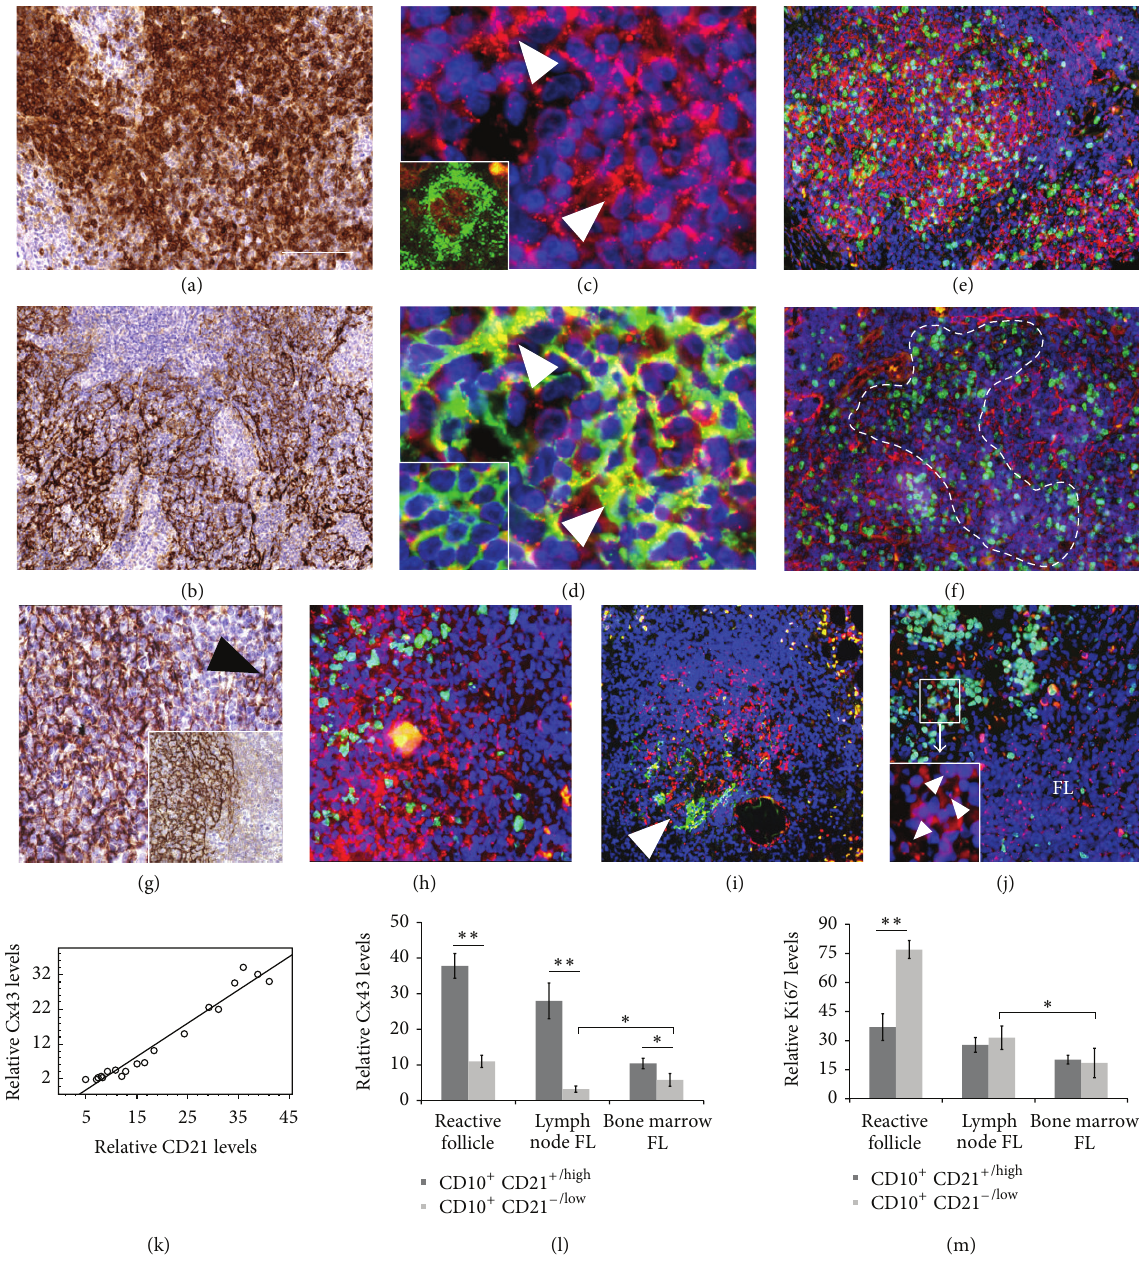
Figure 4: Connexin 43 expression in follicular lymphomas (FL); lymph node localization ((a)–(f)); and bone marrow involvement ((g)–(j)). Large and irregular follicles dominated by CD10 positive FL B cells (a) and fragmented CD21 positive FDC meshwork (b). Cx43 ((c), red) reaction colocalizes with that of CD21 ((d), green) in yellow (arrowheads). Insets show a binuclear FDC with highly upregulated Cx43 ((c), green),and colocalization of Cx43 (red) and CD10 (green) as yellow dots (d). Elevated tumor cell proliferation detected with Ki67 reaction (green) is seen in FL follicles either with dense FDC and Cx43 reactions ((e); red) or with fragmented FDC and Cx43 staining ((f); circled area highlights broken or missing FDC). In the bone marrow involvement of FL NGFR (g) and CD21 (inset) positive follicles (arrowhead: LNGFR positive hyperplastic stromal cells) show the most of Cx43 reaction ((h), red) and proliferating tumor cells (Ki67-green). Strong Cx43 staining ((i), red) is accompanied with only fragmented CD21 reaction (green) in another follicle. Significantly more Cx43 (red) but less Ki67 (green) is detected within a bone marrow FL infiltrate than in the rest of bone marrow (j). Arrowheads in the inset show Cx43 within the boxed area. Graphs reveal linear correlation between Cx43 and CD21 levels in FL (k) and Cx43 (l) or Ki67 (m) expression in FDC rich and FDC poor FL areas. Immunoperoxidase ((a), (b), and (g)) and immunofluorescence staining ((c)–(f) and (h)–(j)). Blue nuclear staining using hematoxylin ((a), (b), and (g)) or Hoescht ((c)–(f) and (h)–(j)). Significance: ∗ 𝑃 < 0.05 and ∗∗ 𝑃 < 0.005 . Scale bar on (a) shows 150 𝜇 m on (a) and (b); 30 𝜇 m on (c) and (d); 120 𝜇 m on (e), (f), (g), (i), and (j); and 100 𝜇 m on